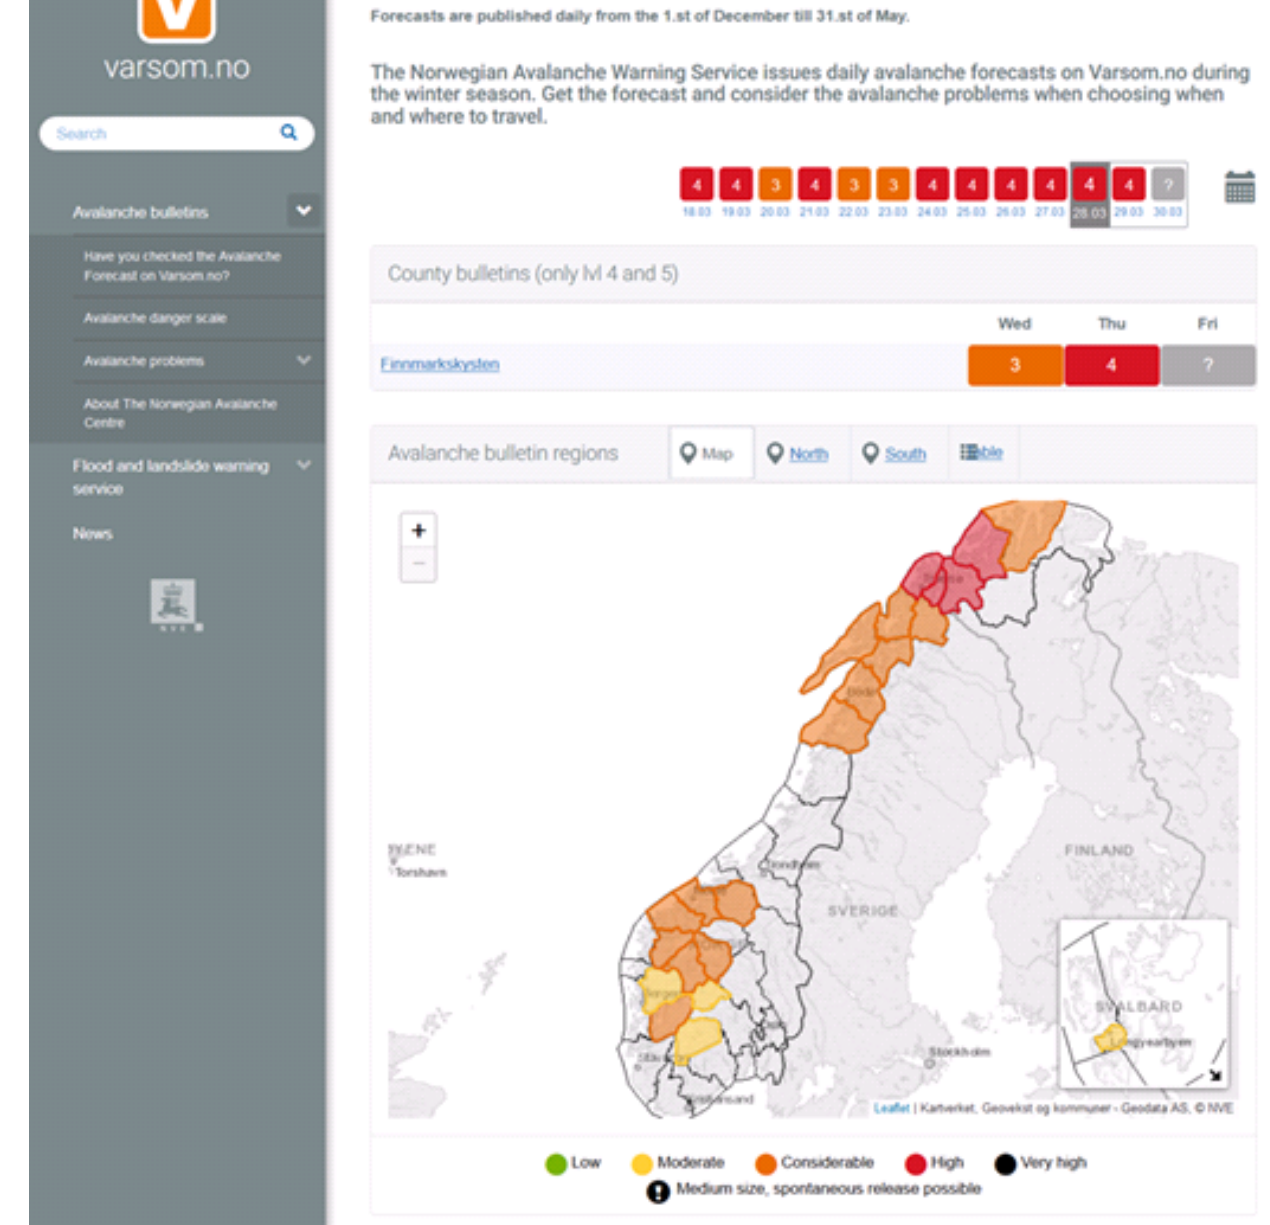
Figure 1. Screen dump from Varsom.no showing the avalanche warning regions in Norway. Daily warnings are published for the regions coloured according to the danger level. The other regions (grey) are monitored and warnings are only published at danger levels 4 and